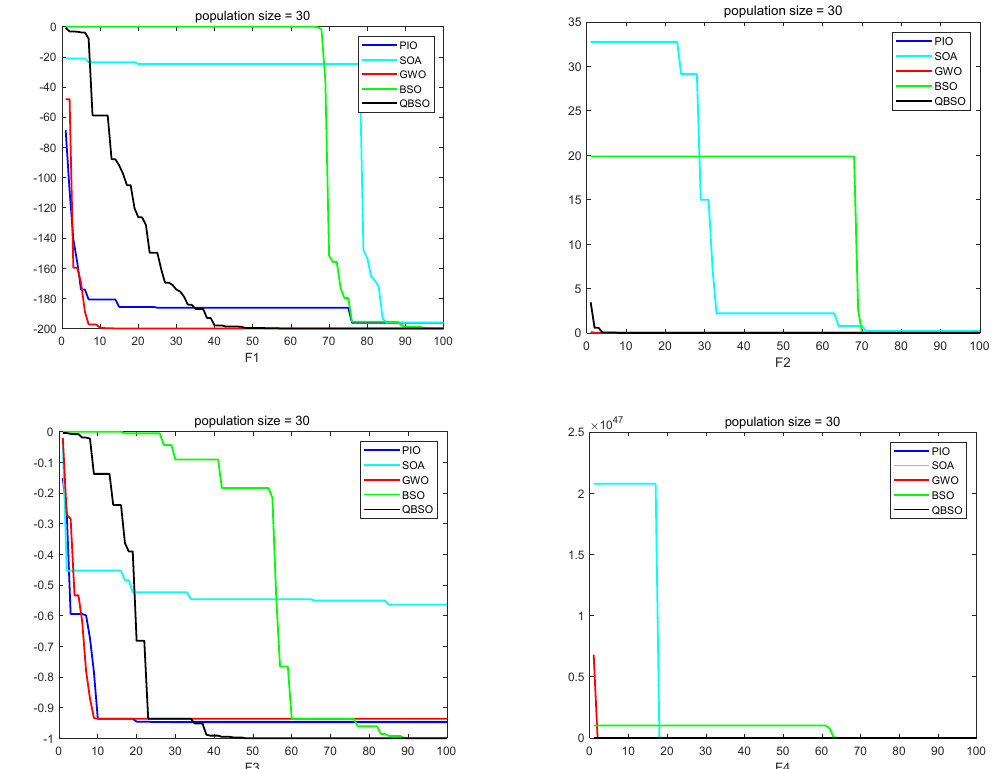
Figure 5. The iteration curves when solving unimodal benchmark functions with four algorithms. For algorithm designers, the accuracy and time consumption of the algorithm are